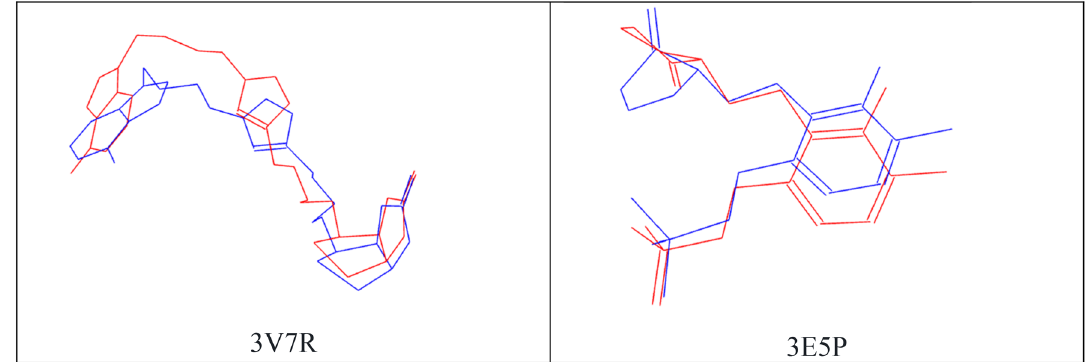
Figure 9. Validation of the 3V7R and 3E5P proteins, red is native ligand conformation before docking process and blue is native ligand conformation after docking